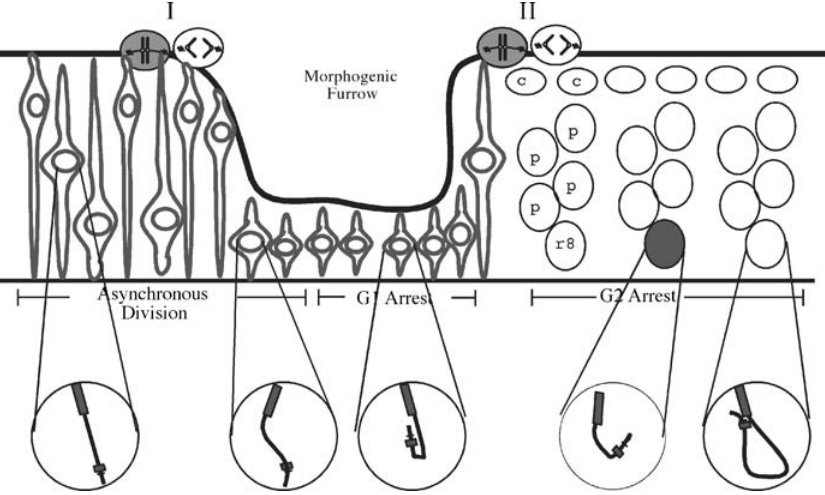
Figure 8. Model of Variegating Gene Association with Heterochromatin and Its Consequences Cartoon of eye disk showing when and where association occurs and its effects on gene silencing. Anterior is to the left. Long-range interactions are not observed anterior to the morphogenic furrow in regularly dividing cells. In the morphogenic furrow, G1 arrest allows variegating genes the time to begin to find and associate with blocks of heterochromatin. Once behind the morphogenic furrow, variegating loci in more cells associate with heterochromatin, and once formed these interactions persist. When a developmental signal is sent for a gene to be expressed, its association with heterochromatin greatly affects its chances for being expressed, such that a gene interacting with heterochromatin is far less likely to be activated than one that is not. DOI: 10.1371/journal.pbio.0030067.g008